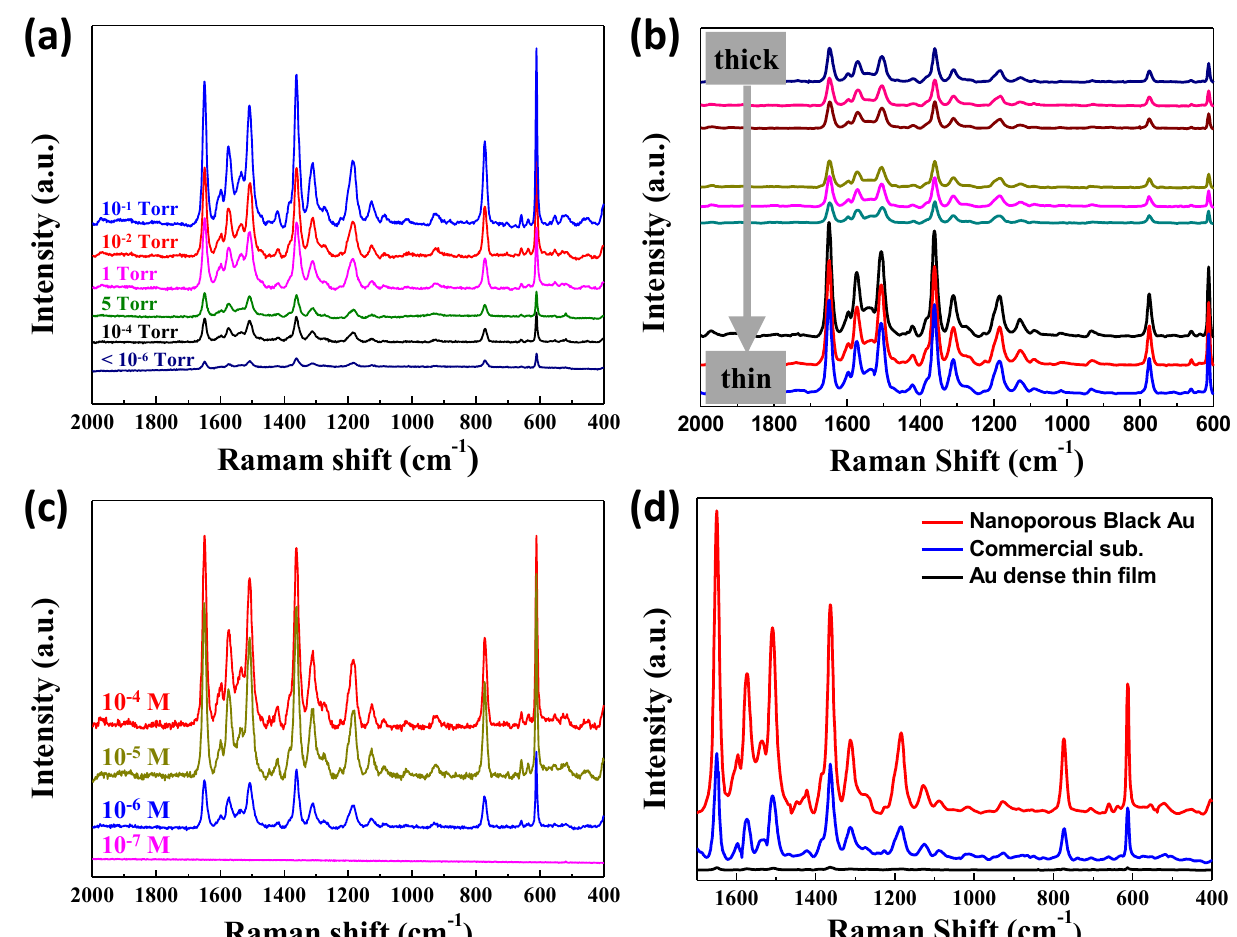
Figure 3. Results of SERS measurement: ( a ) Comparison of SERS spectra obtained from Au nanostructures grown at different pressure; ( b ) thickness dependence of SERS spectra for nanoporous Au grown at 1 Torr; ( c ) comparison of SERS sensitivity among various concentrations of R6G molecules; ( d ) comparison of SERS sensitivity of nanoporous Au to the commercial SERS substrate.